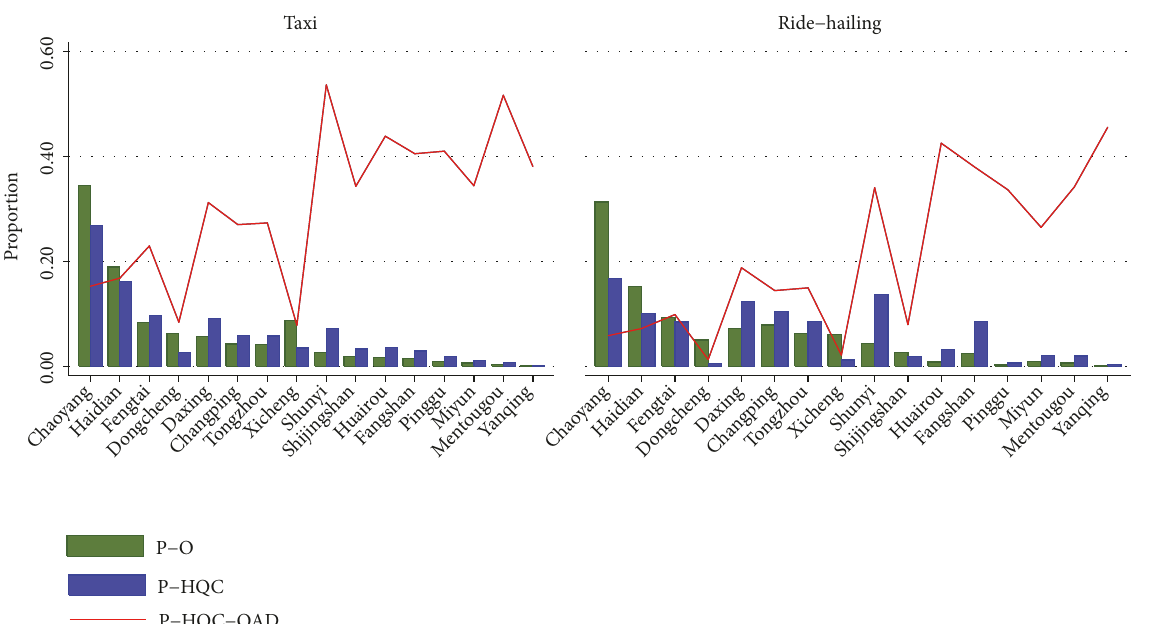
Figure 7: The distributions of orders and HQC in different administrative districts. Note: P-O refers to the proportion of orders in the total orders in the 16 administrative regions. P-HQC refers to the proportion of HQC in the total HQC. P-HQC-OAD refers to the proportion of HQC in the total orders of the corresponding administrative districts.